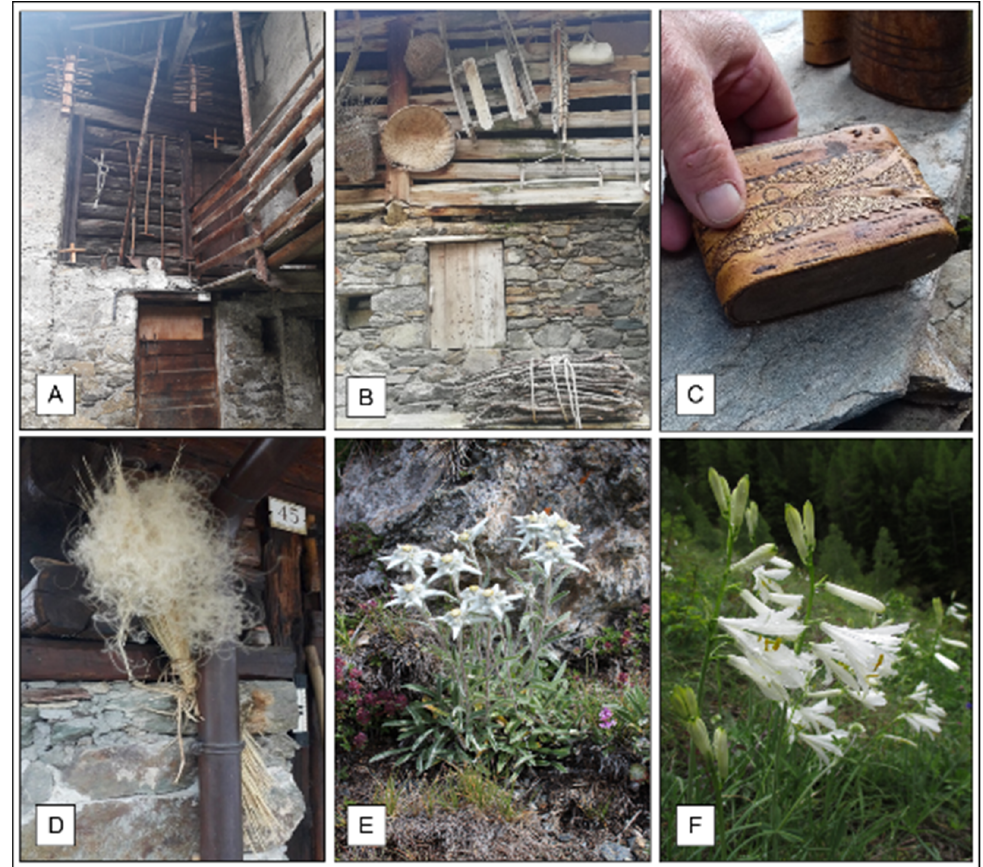
Figure 5. Domestic, handcraft and other uses: ( A ) Handles of tools such as shovels and picks made by Fraxinus excelsior wood, ratelei, used to store the loaves , roofs of the house made by Larix decidua wood; ( B ) baskets and traditional gerle made by Salix sp., other agro-pastoral tools; ( C ) snuff-singer made by Betula pendula cortex; ( D ) Stipa pennata , timepiece plant; ( E ) Leontopodium nivale subsp. Alpinum ; ( F ) Paradisea liliastrum.